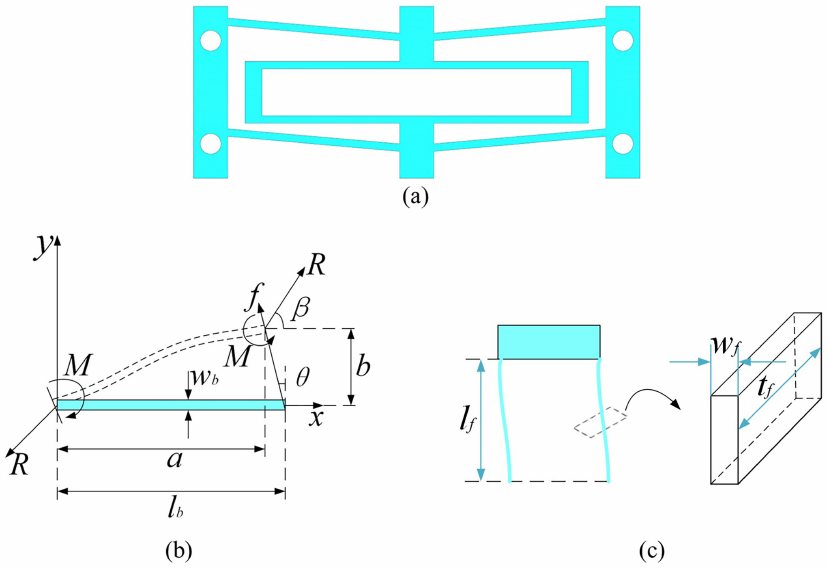
Figure 1. ( a ) The compliant constant force mechanism isometric schematic. ( b ) The sketch of force conditions for a bistable beam. ( c ) Positive stiffness flexure beam and cross